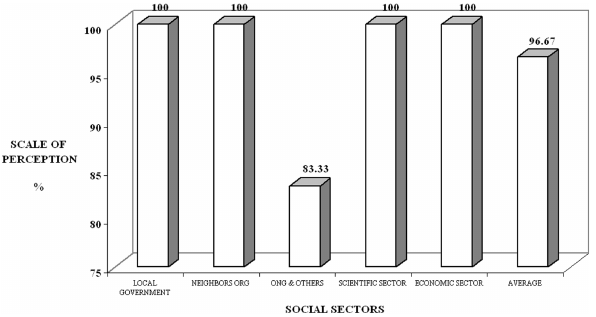
Fig. 5. Perception of vulnerability to flooding. Social sectors of Focus Group sessions.